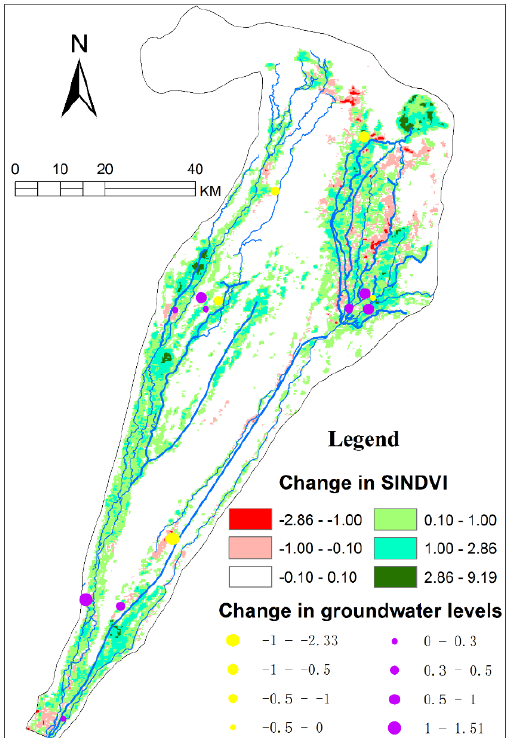
Figure 7. Changes in SINDVI and groundwater levels in the Ejin Oasis between 2000 and